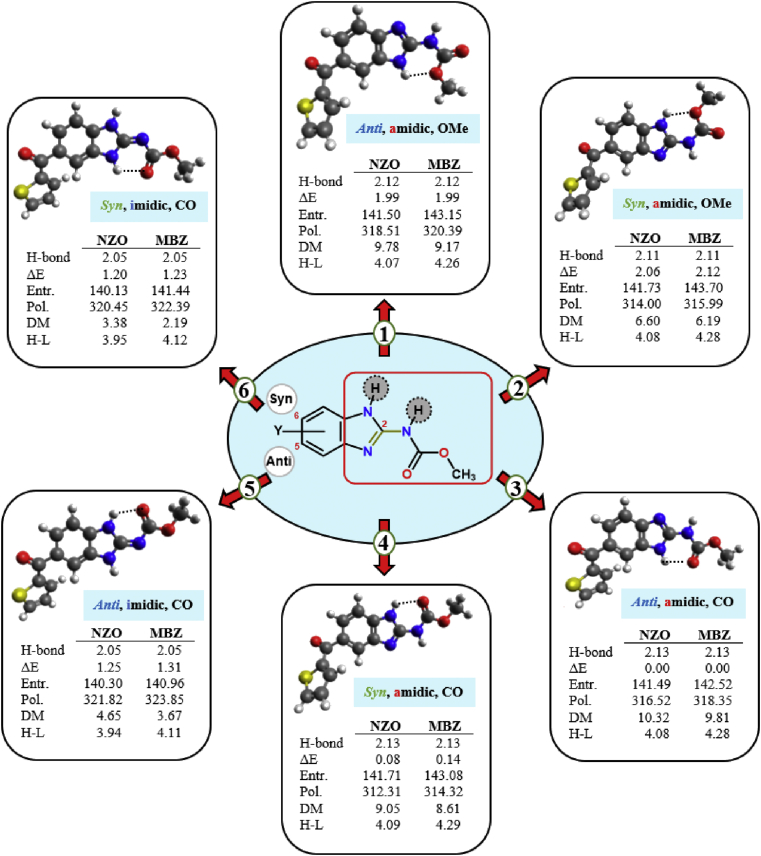
A representative structure of carbendazim-bearing drug where “Y” denotes to aliphatic or aromatic substitution at 5 and/or 6 position on benzimidazole moiety. Energy-optimized 3D structures of Nocodazole in water using B3LYP/6-311+G∗ model. Conformers are characterized based on 1) stereochemistry (Anti or Syn) between 5 (6)-substitution and the hydrogen of carbamate nitrogen (str.1–4) or oxygen of carbamate moiety (str. 5,6); 2) connection of benzimidazole nucleus with carbamate moiety through amidic or imidic bond; 3) intramolecular H-bond formation between hydrogen of benzimidazole nitrogen and oxygen of the methoxy group (OMe) or carbonyl group (CO). Dashed lines refer to H-bonding (in Å) between benzimidazolyl hydrogen and adjacent oxygen. NZO and MBZ denotes Nocodazole and Mebendazole respectively. ΔE (in kcal/mol) refers to change in energy relative to the most stable conformer (str. 3), where E is the electronic energy including zero-point energy correction. Entr. refers to entropy (in cal/mol-kelvin), Pol. Refers to polarizability (in a.u.), DM refers to dipole moment (in debye), and H-L refers to HOMO-LUMO energy gap (in eV).